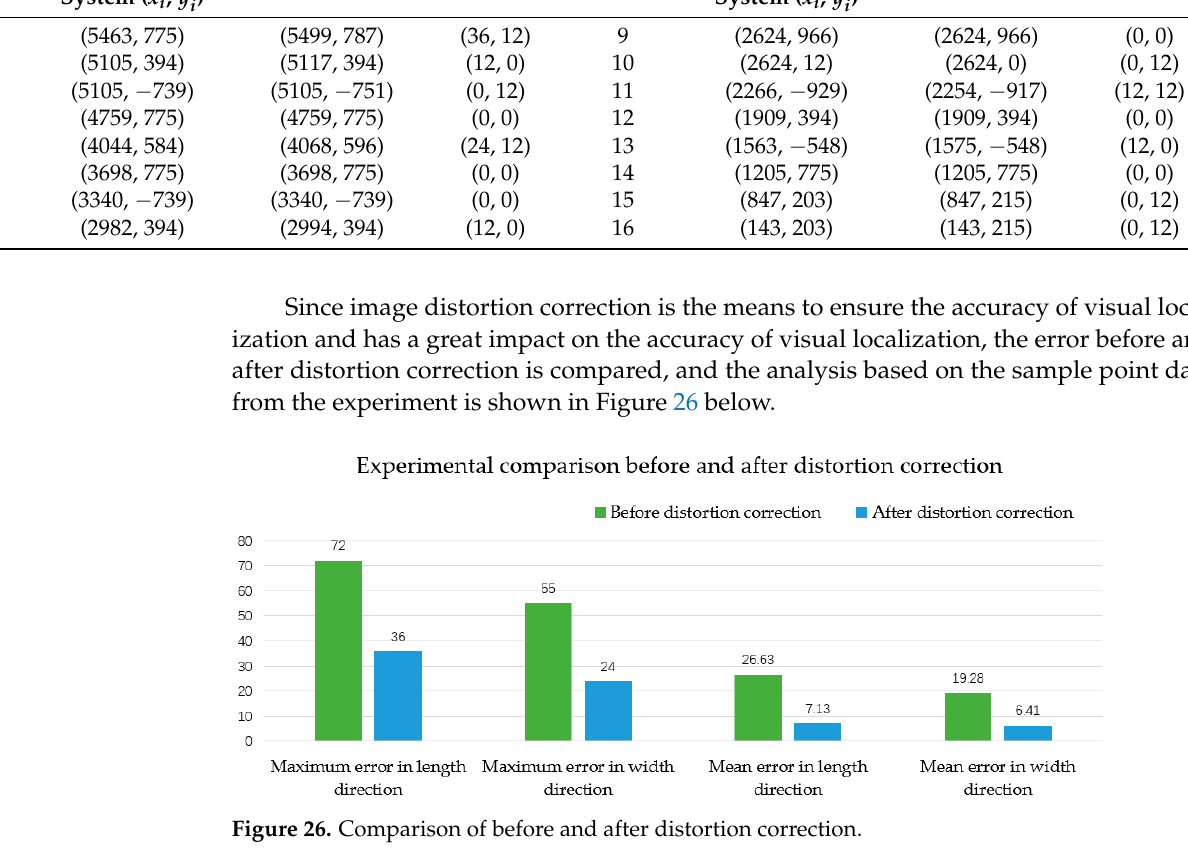
Figure 27. Absolute error in the x-direction and y-direction before and after distortion correction. Due to the inaccurate localization of the sampling robot in the sampling process, re- sulting in sampling points being identified beyond the sampling area, according to the sampling point error range requirements, the randomly generated sampling points have a 152.78 mm error margin in the x-direction and an 83.33 mm error margin in the y-direc- tion from the boundary of the sampling area, as shown in Table 8. Table 8. X-direction and y-direction localization error range requirements. Parameters